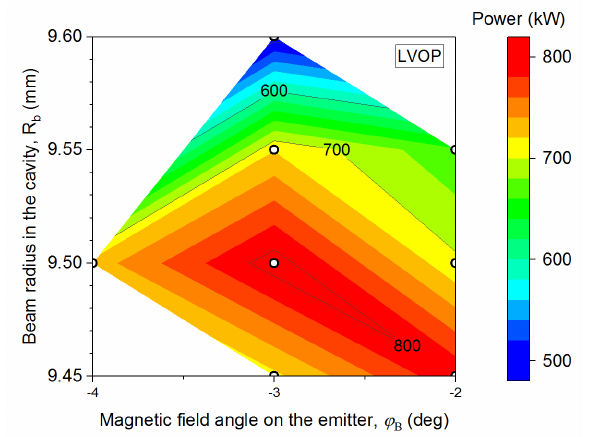
Fig. 7. RF power with respect to the magnetic field angle at the emitter and the radius of the electron beam in the cavity. Operation at the LVOP with long pulses (> 60 s).